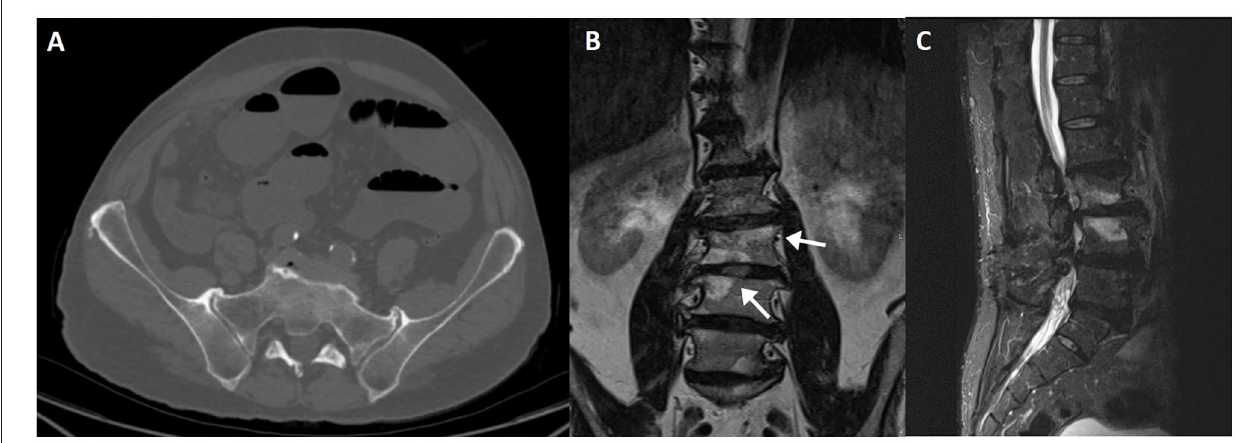
FIGURE 5 | CT axial slice showing degenerative changes of the sacroiliac joint (A) , with marginal osteophytes and bone sclerosis. Modic endplate changes at the weight bearing surfaces of the distal lumbar spine (arrows), seen on coronal T1 (B) and sagittal fluid-sensitive (C) sequences. Bone marrow signal changes are high on T1WI and fat-saturated T2WI, compatible with Modic type